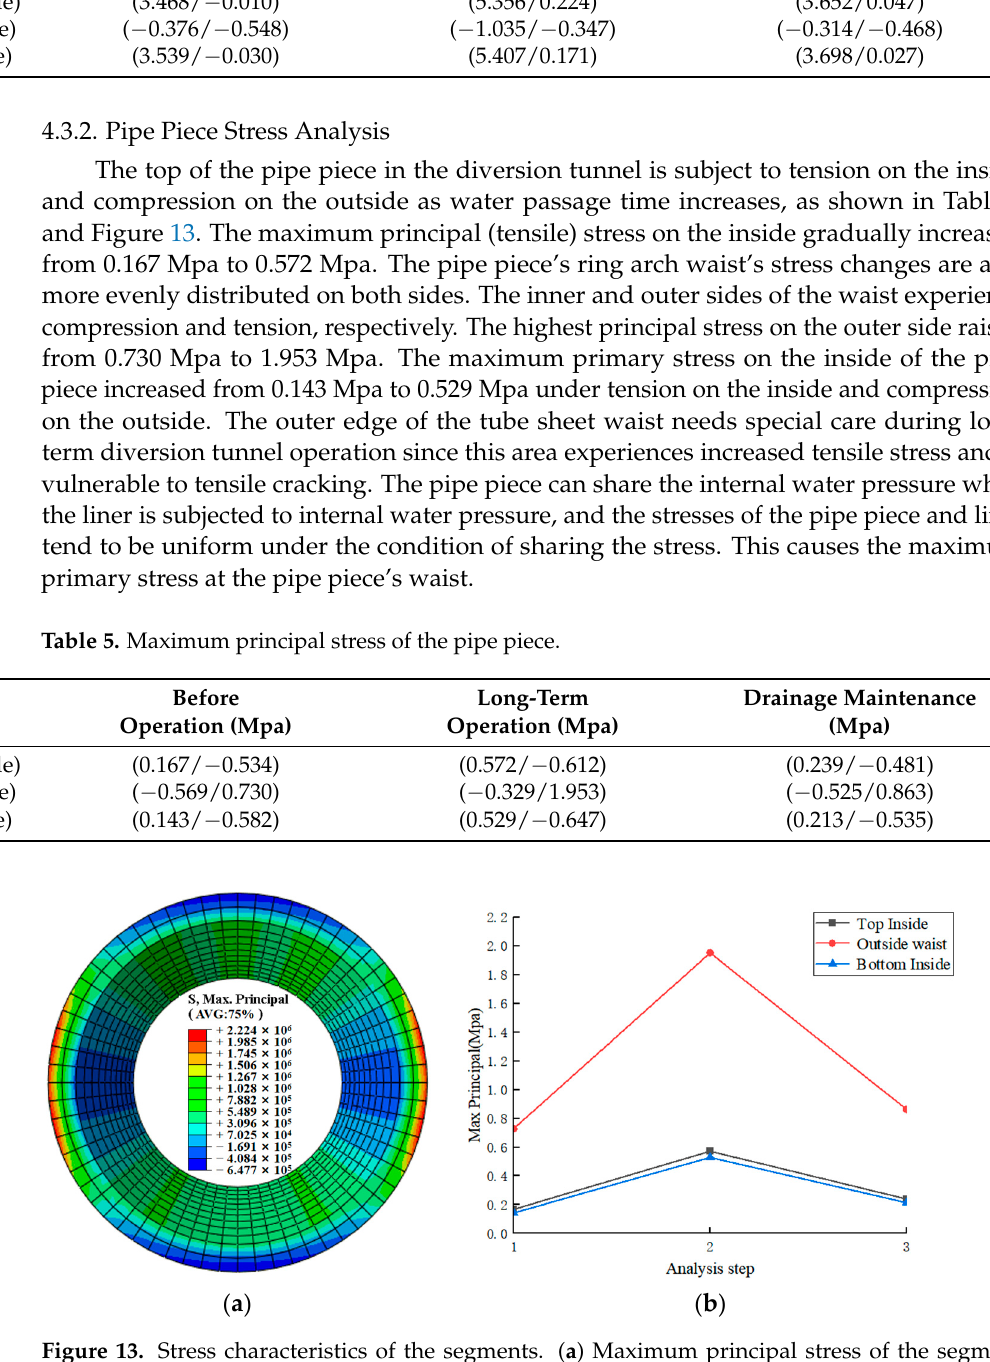
Table 4. Maximum principal stress of the lining.